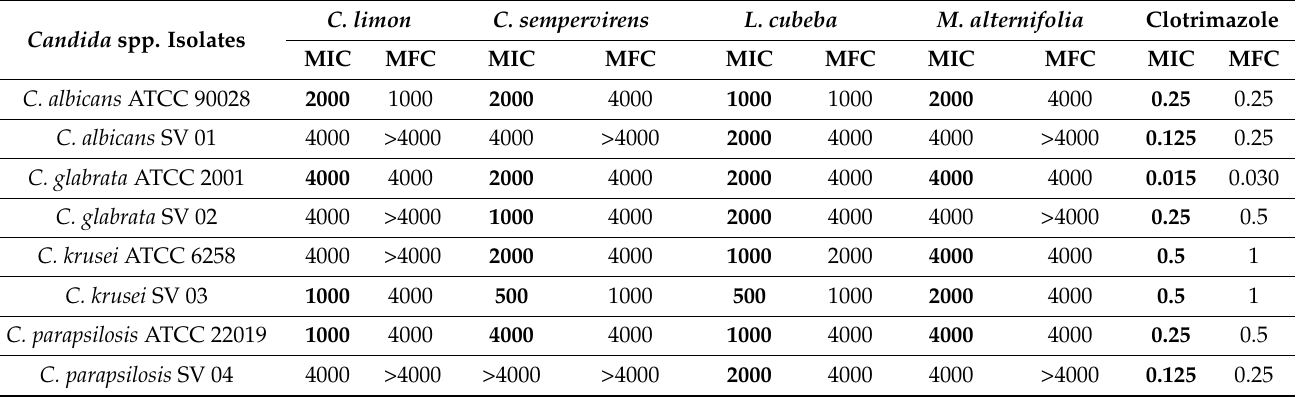
Table 2. Minimum inhibitory concentration ( µ g/mL) and minimum fungicidal concentration ( µ g/mL) of essential oils and clotrimazole tested with Candida